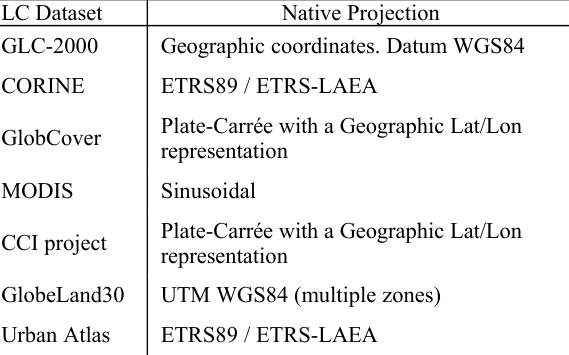
Table 3. Native projection of the LULC